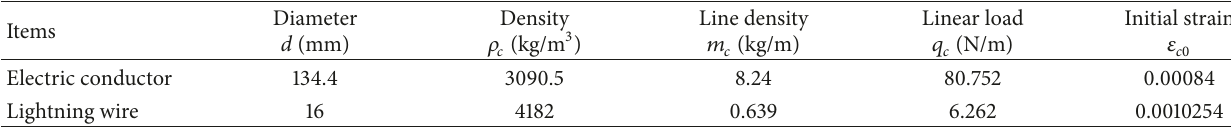
Table 3: Parameters of the transmission lines after equivalent